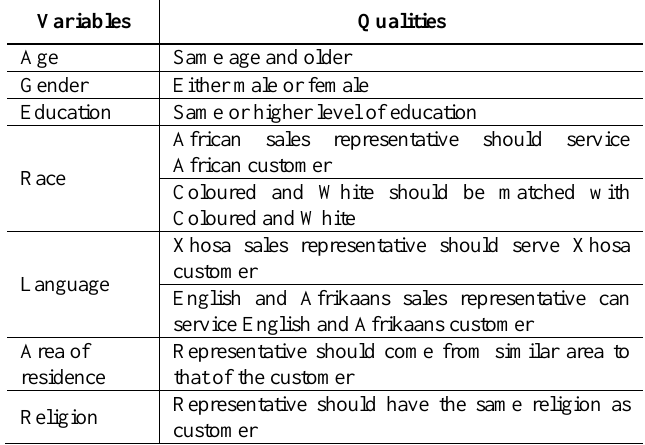
Table 1: The “ultimate” sales